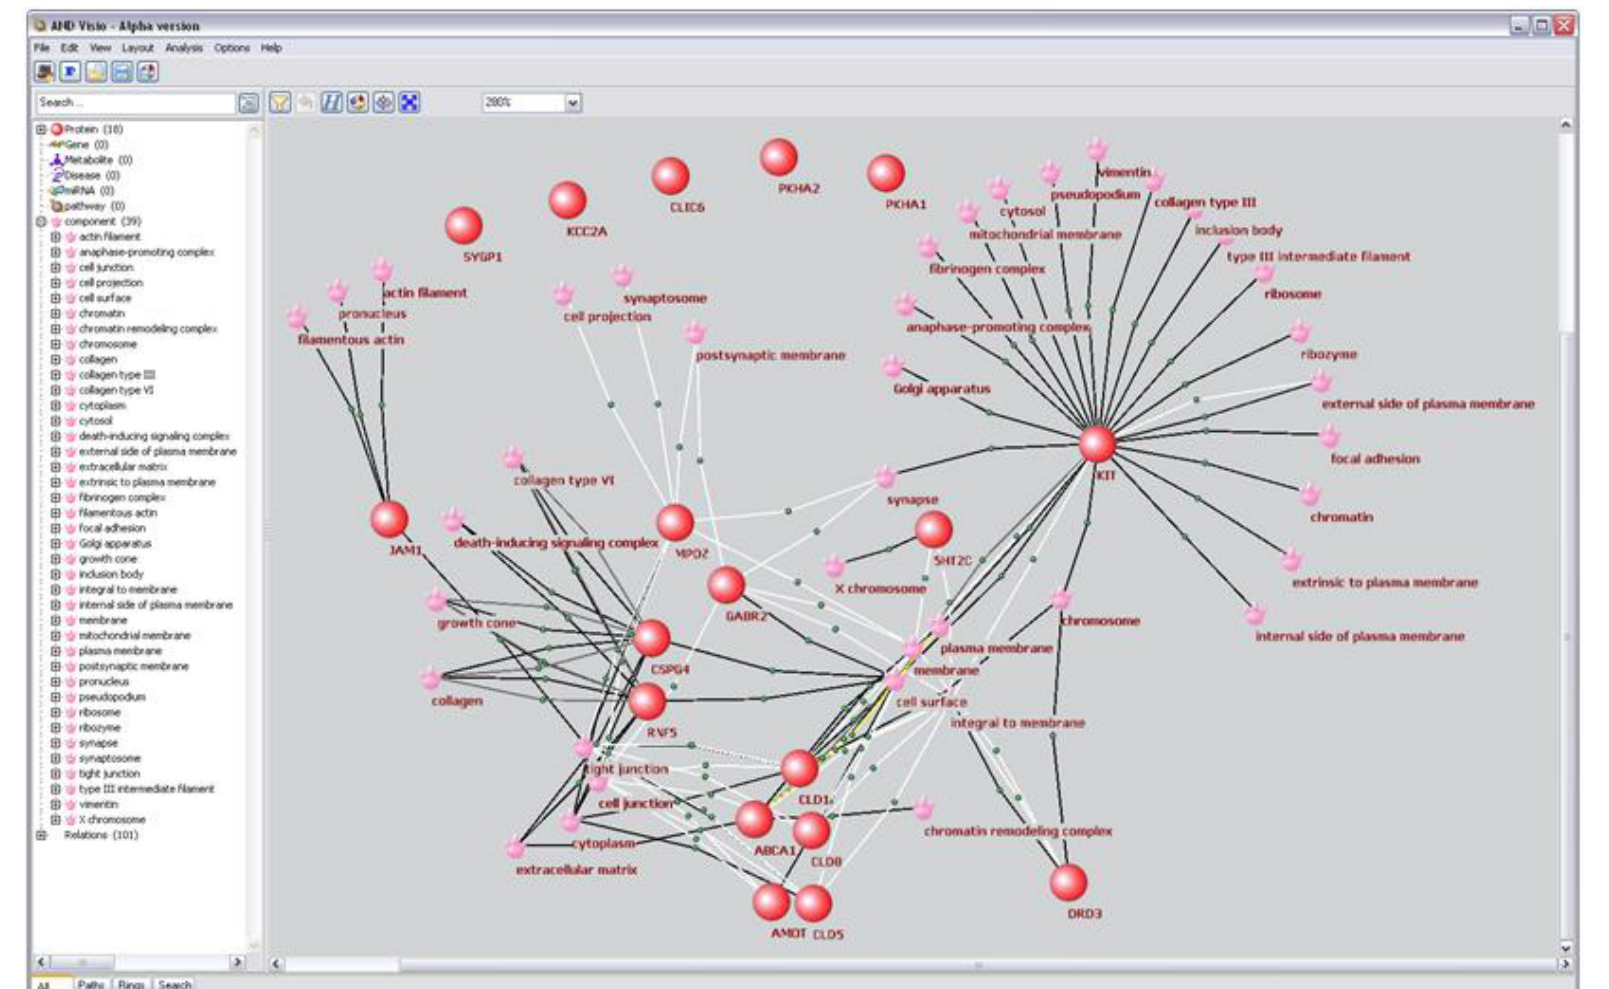
Figure 6: The sub-network shown in Fig. 2 supplemented by using ANDVisio and its Localization results extracted from PubMed entries. The protein identifiers are here synonyms for the identifiers used in VANESA. Six proteins are not localized: PKHA1 (PLEKHA1), PKHA2 (PLEKHA2), KCC2A (CAMK2A), CLIC6, CLD8 and SYGP1 (SYNGAP1). Localization descriptions obtained by ANDVisio have different detail levels. For example the KIT protein is connected to the following descriptions related to the cell membrane: cell surface, plasma membrane, pseudopodium, external/internal side of plasma membrane and extrinsic to plasma membrane. Grey lines show “interactions”, black lines show “association” and the yellow line shows an “activity